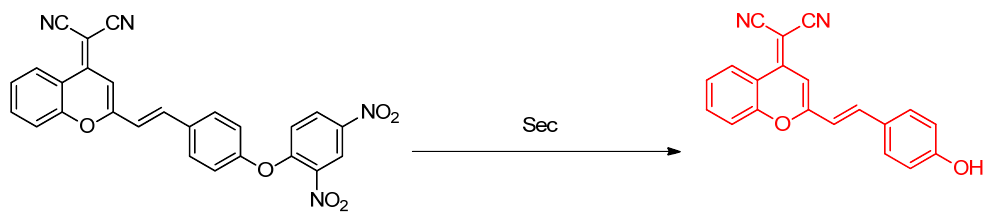
Figure 49. The structure of probe 1 analyzed for selenocysteine based on the 2,4 dinitrophenyl motif by Li et al.